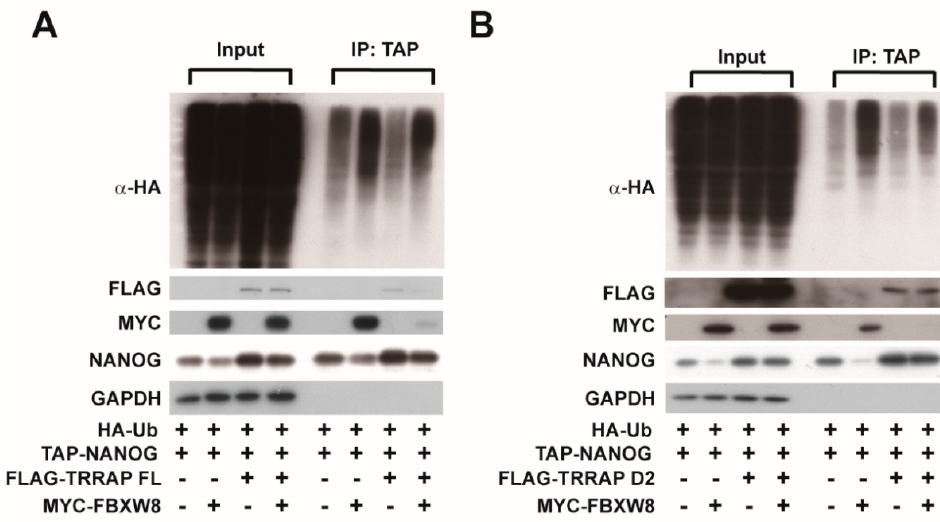
Figure 3. E ff ect of TRRAP overexpression on the FBXW8-mediated ubiquitination of the NANOG Figure 3. Effect of TRRAP overexpression on the FBXW8-mediated ubiquitination of the NANOG